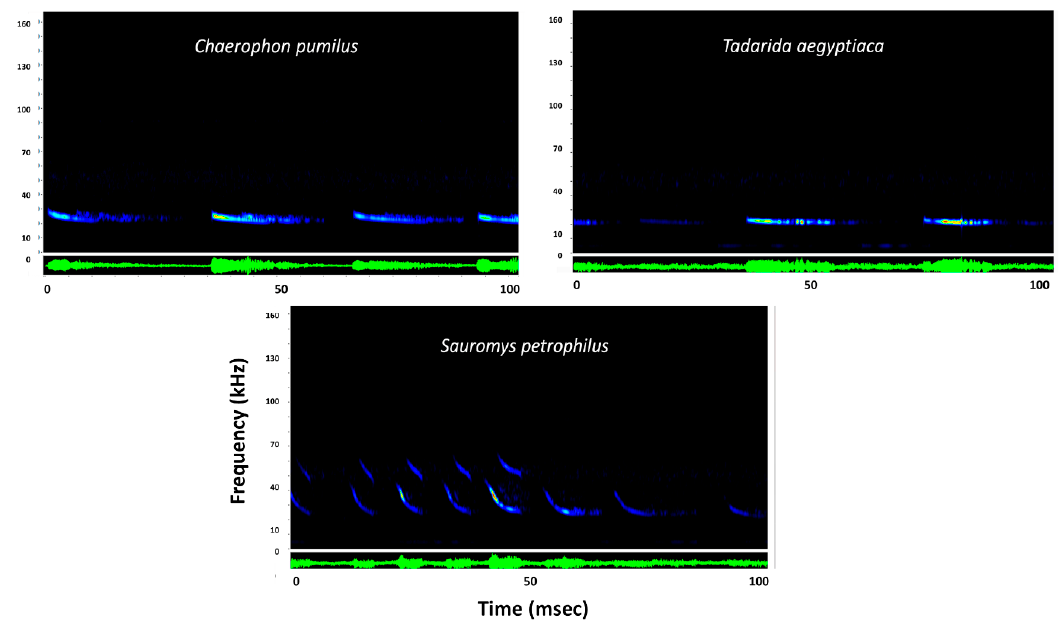
Figure 3. Representative sonograms for three bat species from the family Molossidae presented using Sonobat 4.1. Y -axis is frequency in kilohertz (kHz) and x -axis is time standardized over 100 milliseconds (msec). Blue coloration indicates lowest sound intensity of the call, yellow indicates medium intensity, and red indicates highest intensity or loudest portion of the call. Green display represents an oscillogram of the call sequence.